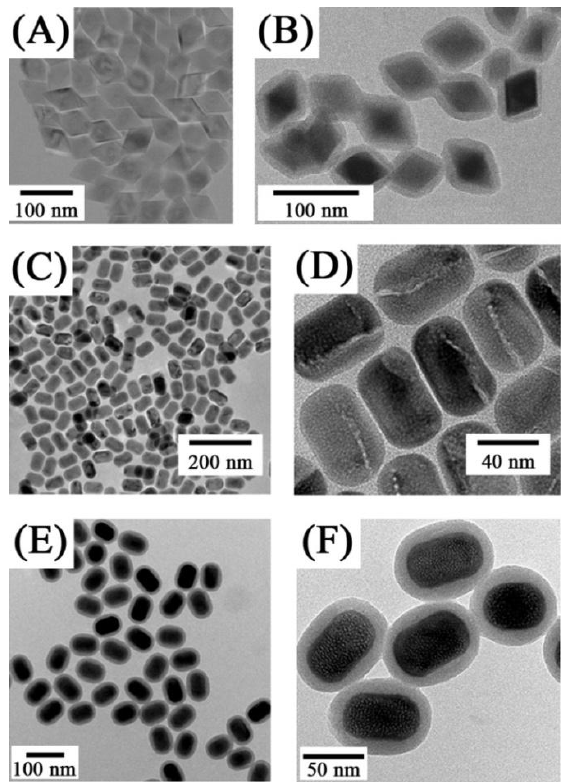
:Yb 3+ , Tm 3+ nanocrystals ([28]) ( A ) before and ( B ) 4